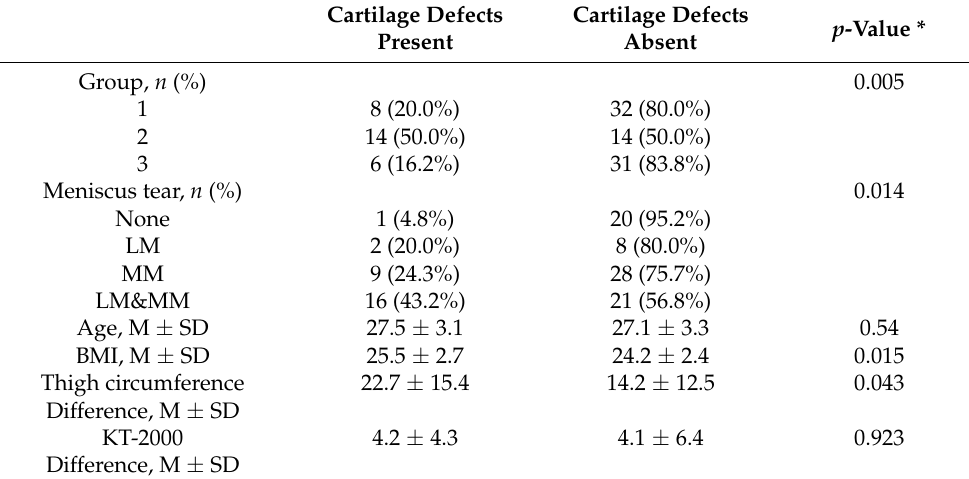
Table 2. Relationship with cartilage